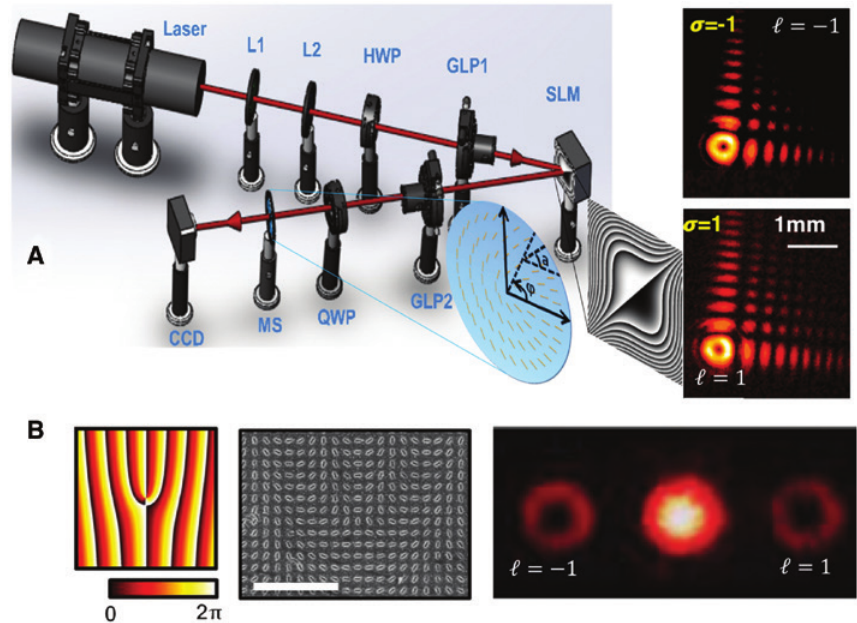
Figure 5: Multifunctional optical vortex generation by hybrid phase plates. (A) Schematic and intensity profile of Airy-vortex beam generation by independent dynamic and geometric phase modulation. Reprinted from Ref. [149]. (B) A geometric phase metasurface hologram generates optical vortex beams and splits the spins simultaneously. Reprinted from Ref.